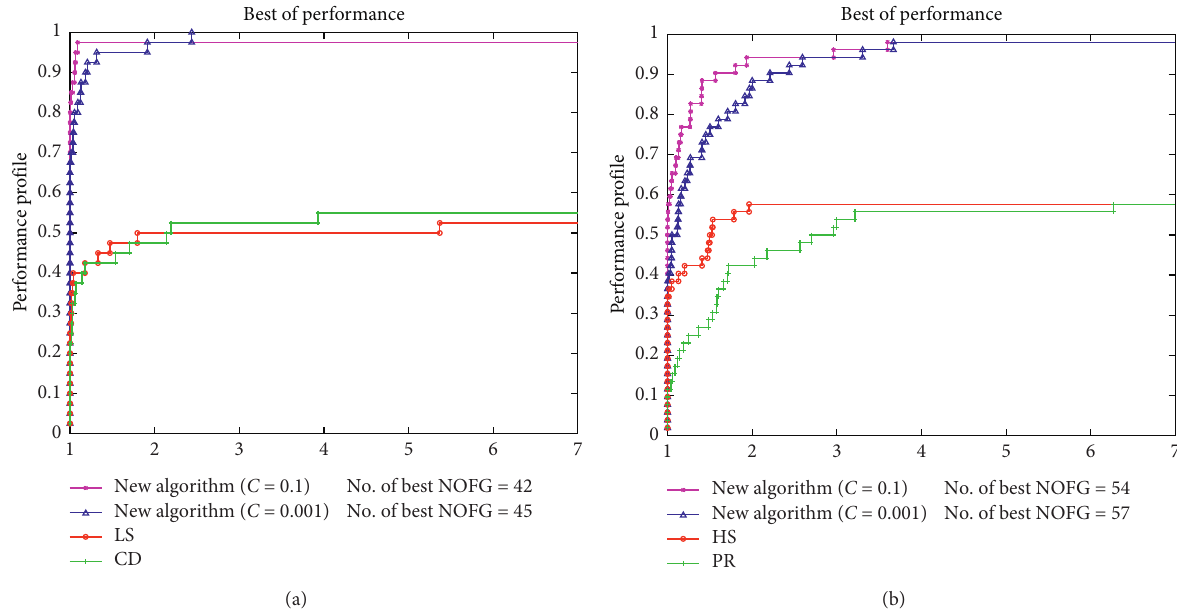
Figure 5: Performance profiles based on the best NOFG. (a) Comparison of the new algorithm vs. LS and CD. (b) Comparison of the new algorithm vs. HS and